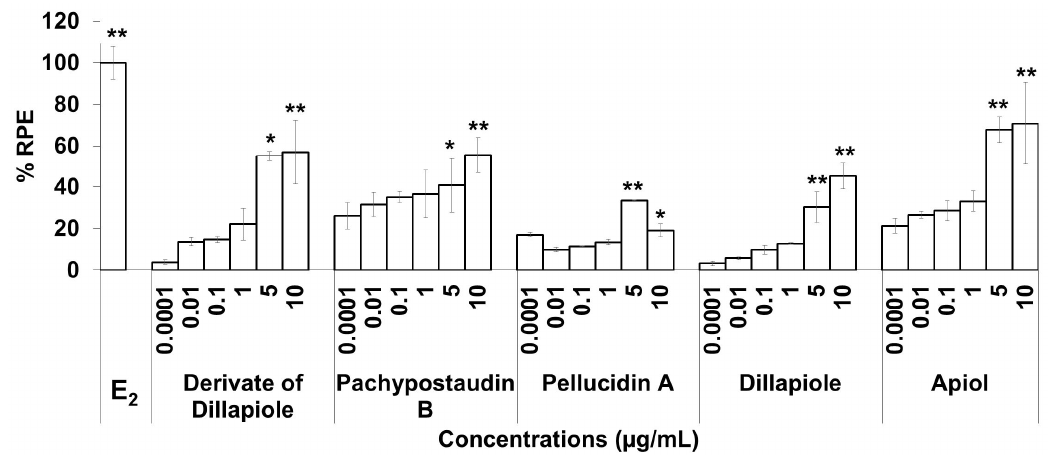
Figure 4. The estrogenic activity of five compounds isolated from the ethyl acetate extract of P. pellucida using the E-SCREEN assay. Cells were treated with the compounds in a dose range of 0.001–10 µ g / mL for 144 h, and relative proliferative e ff ects on the cells were then investigated using sulforhodamine b (SRB) assays, with 10 − 9 M E 2 as the standard control. The data are expressed as the mean ± SD of at least two separate experiments with duplicates or triplicates for each group. The symbols * and ** represent statistical di ff erences compared with the vehicle group: * p < 0.05, ** p < 0.01, analyzed by the Kruskal–Wallis test using Bonferroni adjustment.